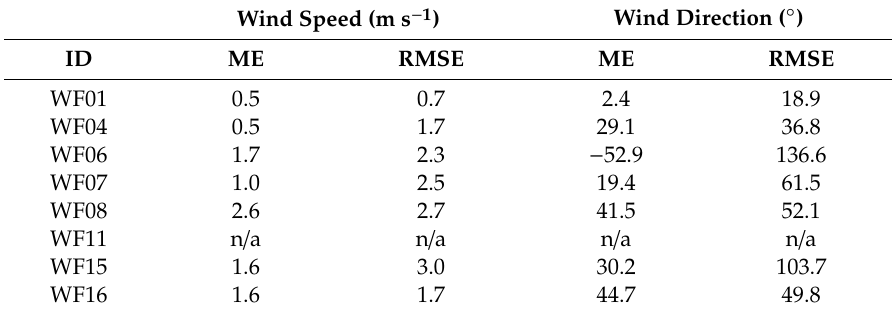
Table 3. Statistical evaluation of IRIS’s wind speed and direction forecasts during the 2019 fire season. Note that for WF11, the evaluation could not be conducted due to the unavailability of valid observed data (i.e., all wind measurements failed to pass the threshold value of 2 m s − 1 ; Section 2.3).